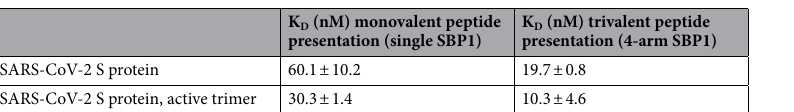
Table 2. Dissociation constants for monovalent and trivalent peptide presenting DNA nanostructures to two spike